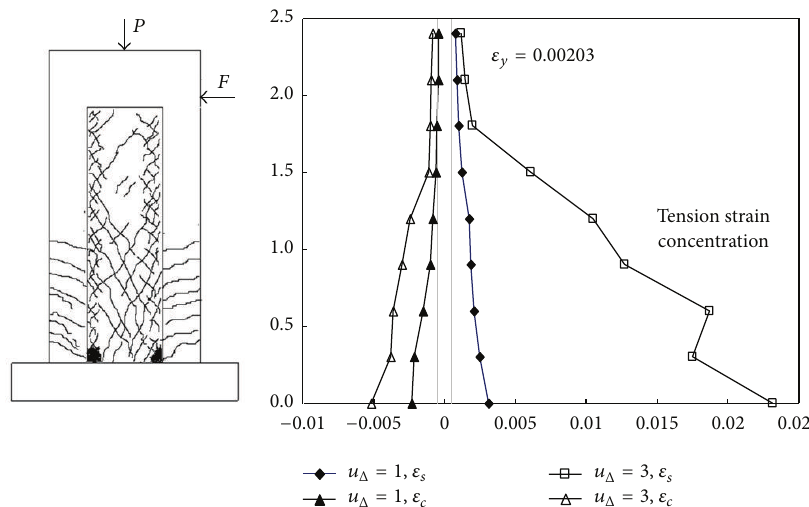
Figure 5: Comparison of crack pattern with experimental strain distributions of Specimen P4.